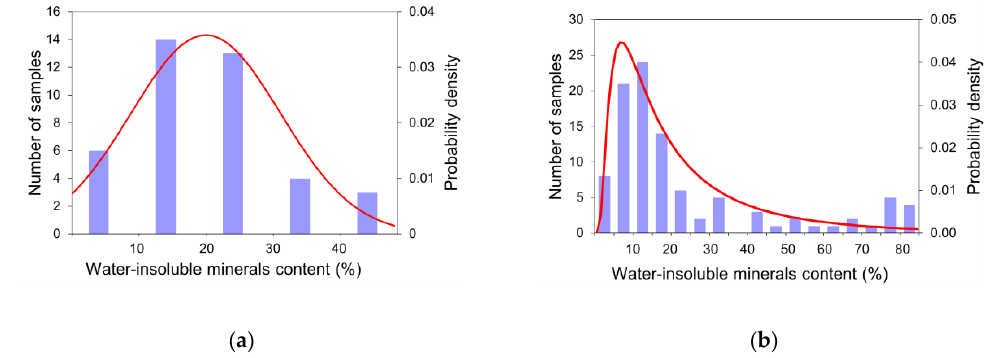
Figure 3. Distribution of the water-insoluble minerals content distribution in the Brown Zuber unit samples taken in the first ( a ) and the second ( b ) phase of the research.